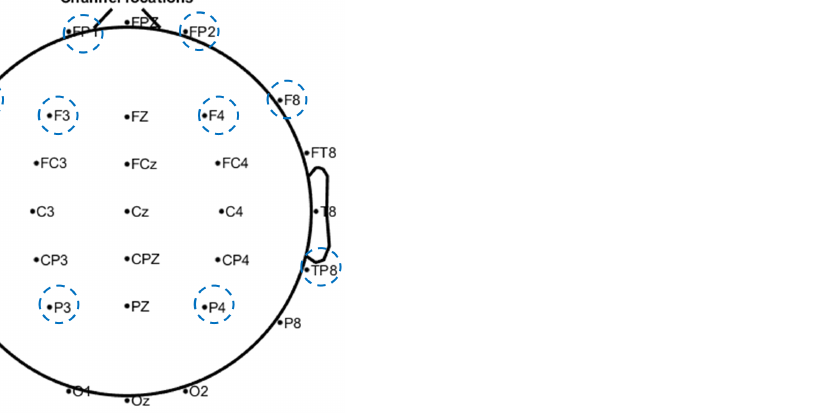
Figure 8. Electrode channels for the MITSAR-EEG-202-31. Circled electrode channels are used for EEG analysis.